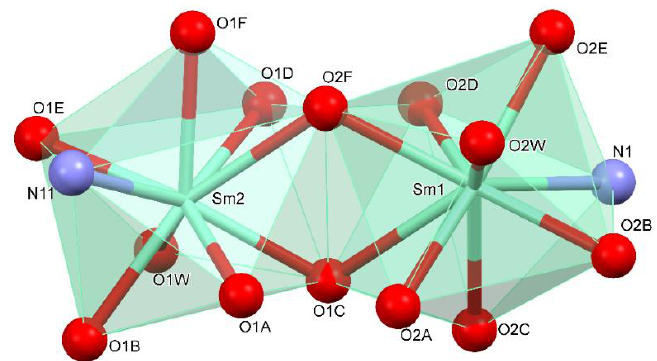
Figure 6. The samarium coordinate polyhedron.